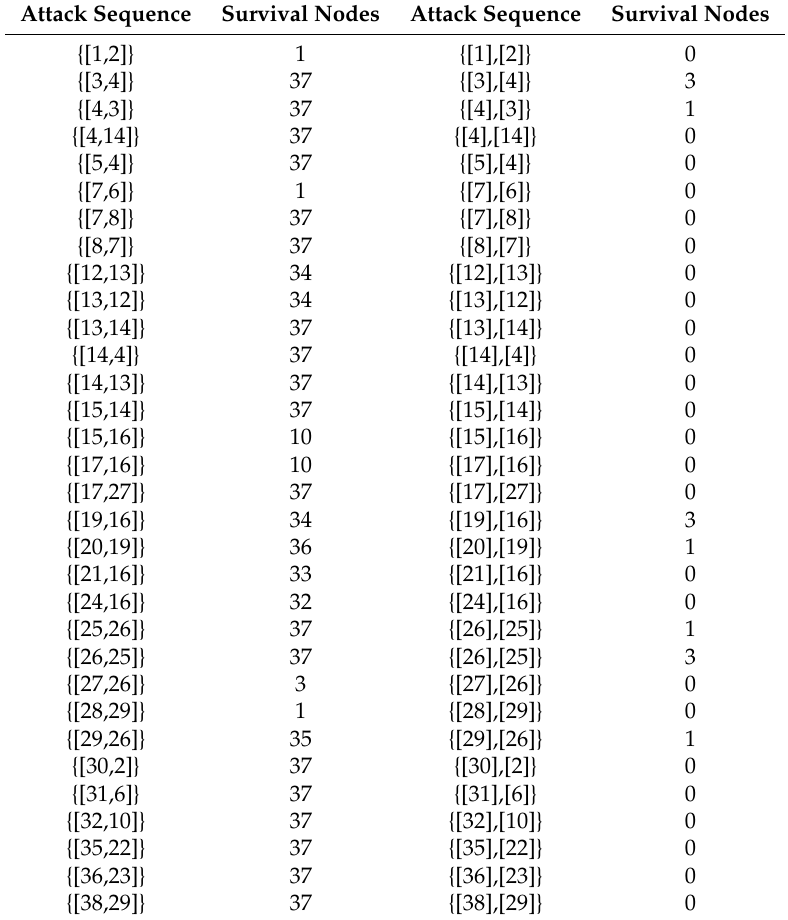
Table 2. Target sets with whom sequential attack would cause more damage. Attack